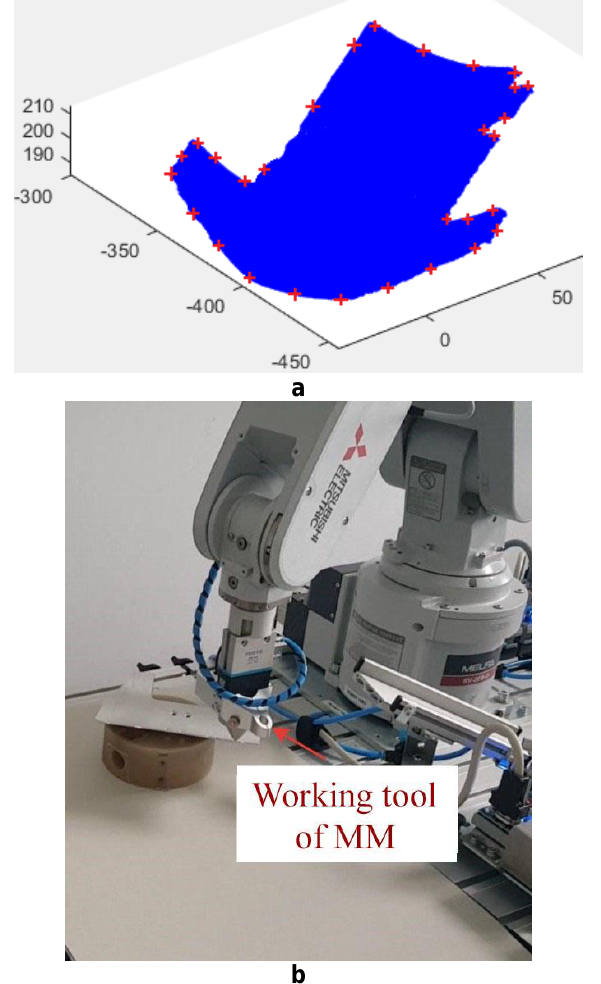
Figure 7. An illustration of the procedures for transferring processing points (red crosses) from the CAD model to the model of the deformed part obtained during scanning (a) and the realization of the trajectory of processing by the working tool of MM (b)